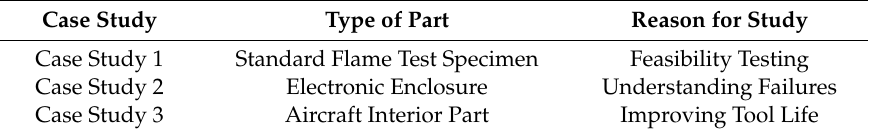
Table 1. The type of part, and the reason for each of the case